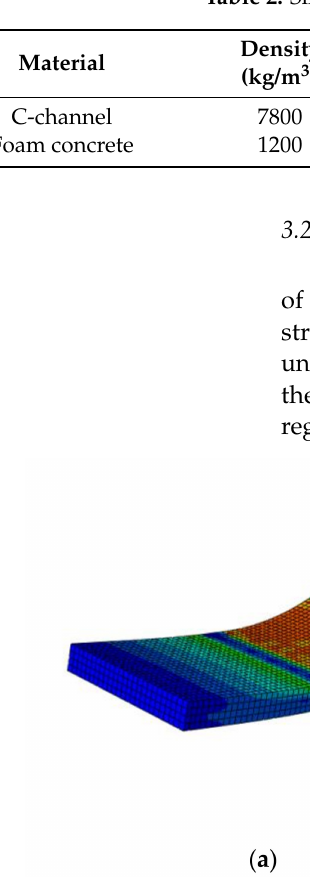
Table 2. Simulation of the foam concrete and cold-formed thin-walled C-channel.